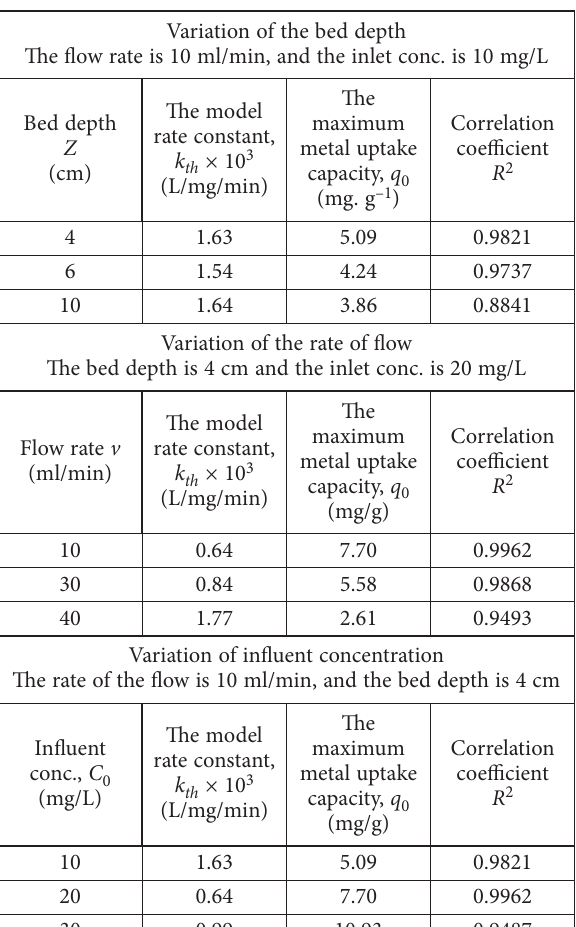
Figure 6. Effect of the influent concentration Table 1. Thomas model